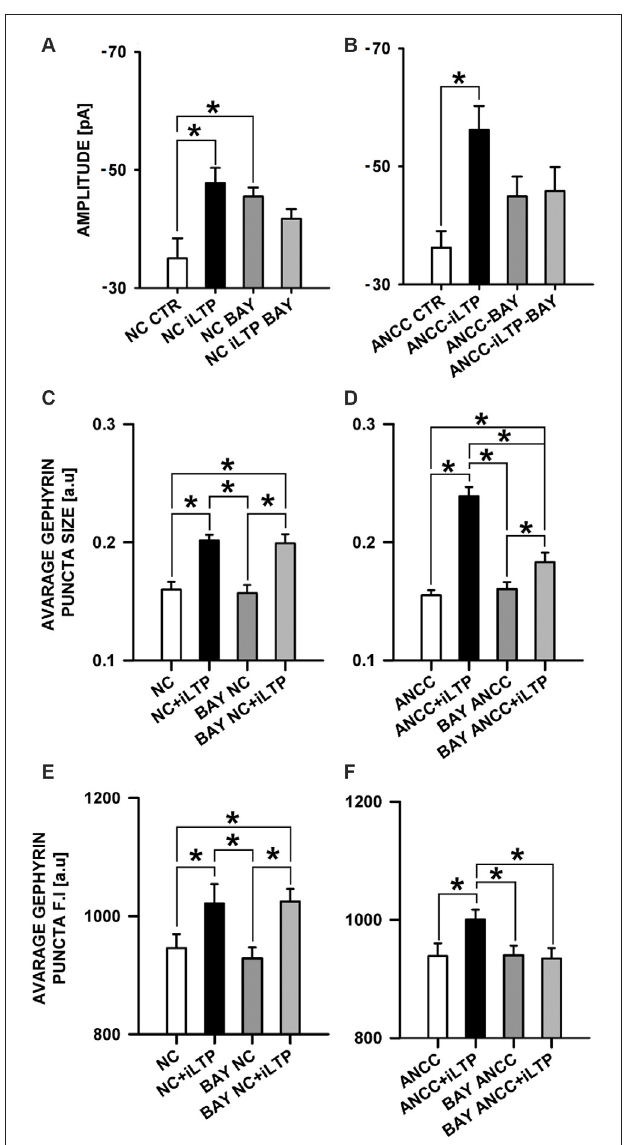
FIGURE 7 | Impact of inhibition of glycogen phosphorylase by BAY U6751. BAY treatment prior to iLTP induction prevent morphological changes in ANCC. (A) Average mIPSC amplitude in NC, (B) average mIPSC amplitude in ANCC. Note that BAY U6751 increases mIPSC amplitudes both in NC and ANCC prior induction of iLTP. This effect renders difficult interpretation of these electrophysiological effect (see “Results” Section). (C) Average gephyrin puncta size in NC, (D) average gephyrin puncta size in ANCC, (E) average gephyrin puncta fluorescence intensity in NC, (F) average gephyrin puncta fluorescence intensity in ANCC. Control group (white bar), NMDA stimulated group (black bar), group treated with BAY (dark gray), group treated with BAY prior to iLTP induction group (gray bar). Star mark represent statistical significant data ( p < 0.05).